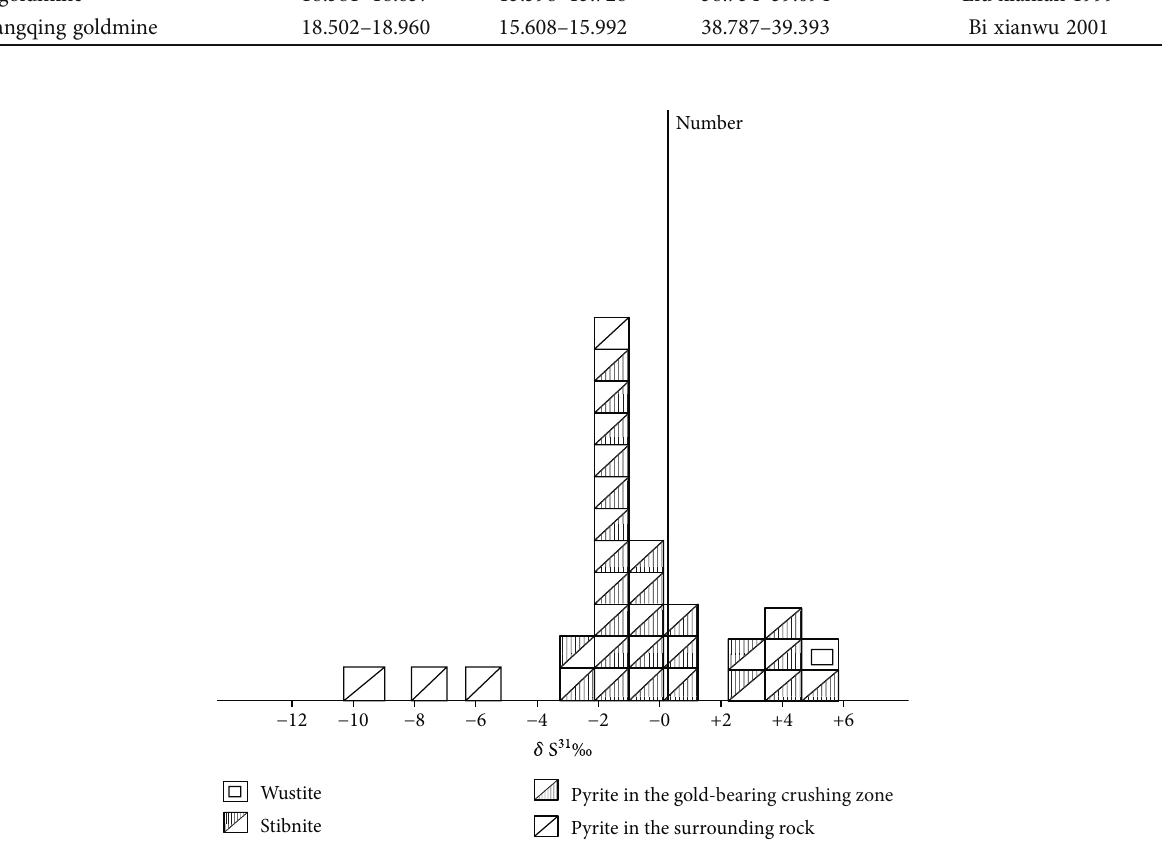
Figure 2: Sulphur isotopic composition and distribution in Zhacun goldmine. Table 3: Isotopic determination results of δ D and δ 18 O in Zhacun